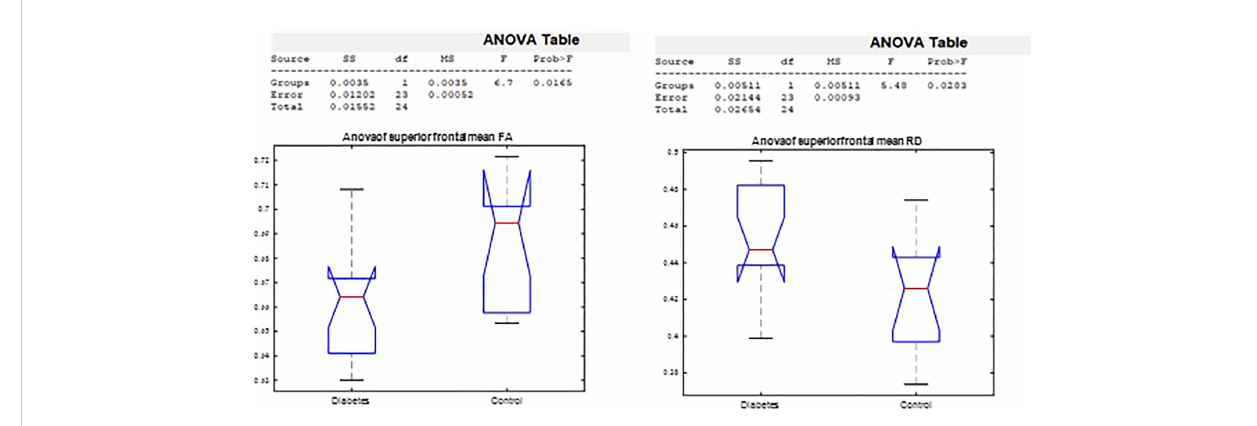
FIGURE 7 Analysis of variance by group in the superior frontal FA and RD corpus callosum segment center.